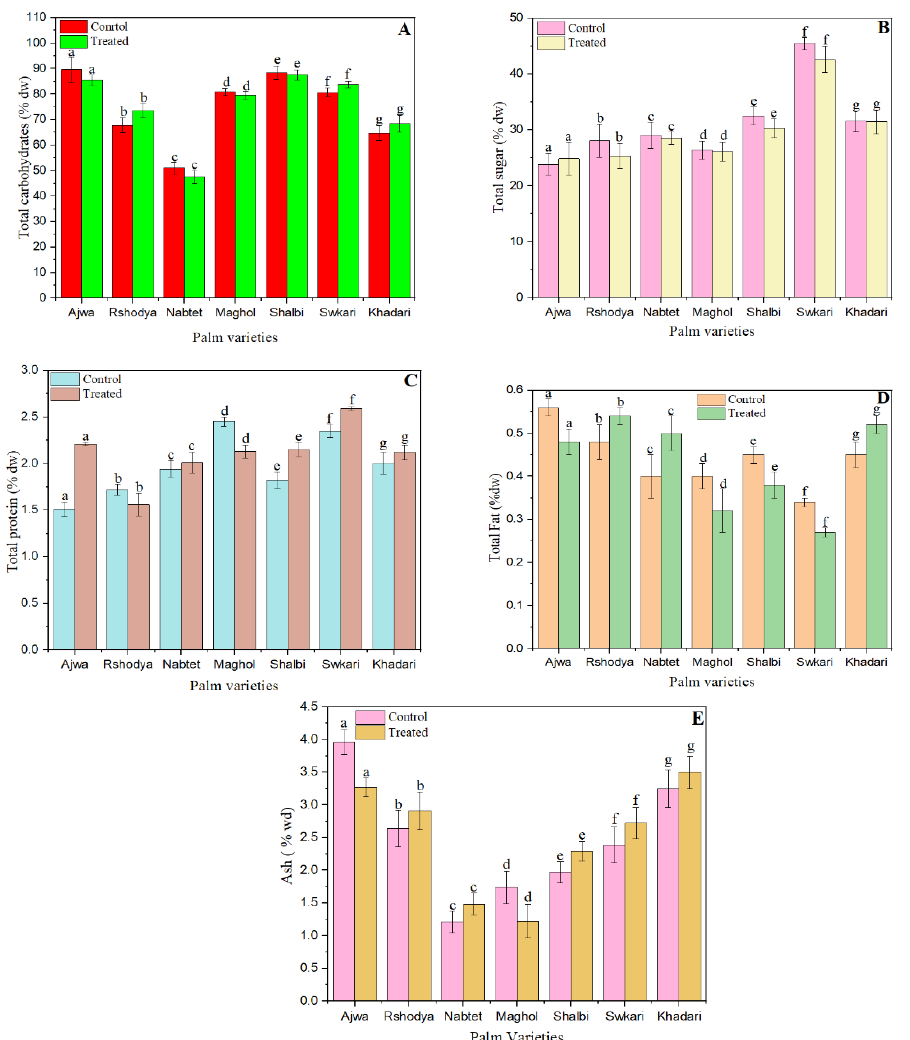
Figure 3. The effect of SDBD plasma on composition of palm dates; ( A ) total carbohydrates, p value = 0.75, ( B ) total sugars p value = 0.34, ( C ) total protein p value = 0.06, ( D ) total fat p value = 0.48, and ( E ) ash p value = 0.25, lowercase letters a–g in the same column represent significance analysis; the different letters mean significant difference among various treatments at p < 0.05 level.